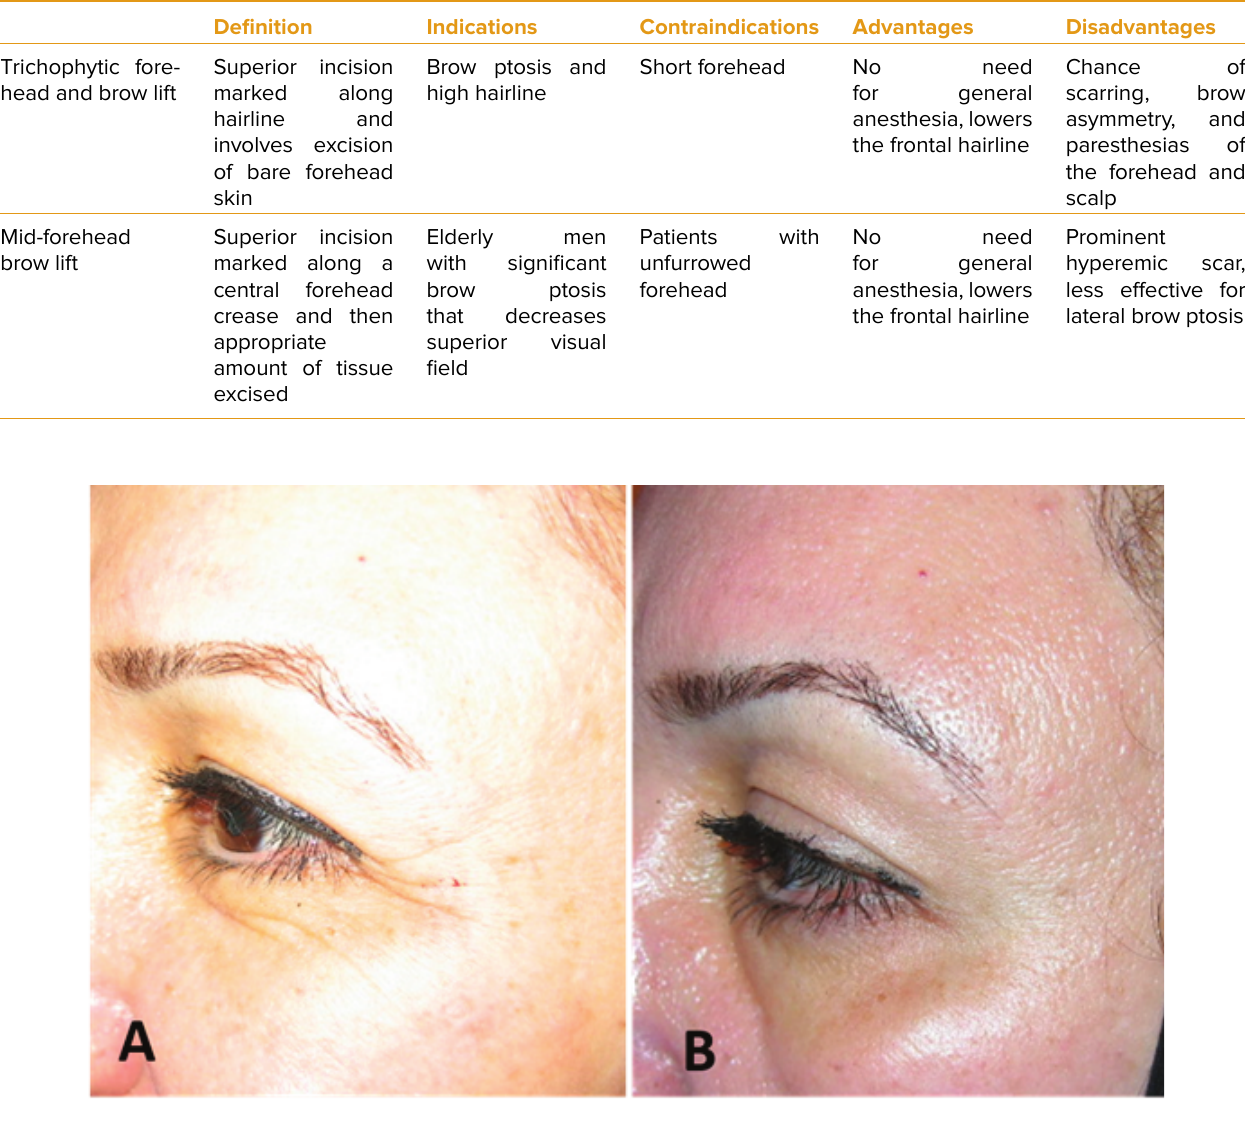
Figure 1. Before (A) and after (B) botulinum toxin A injection for the lateral eyebrow